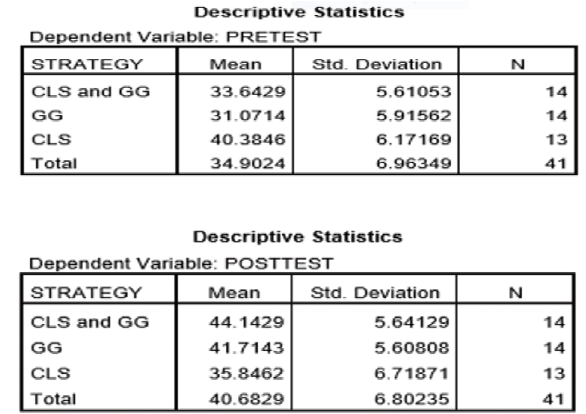
Table 5. Variations of students’ engagement in different strategies for the pre and